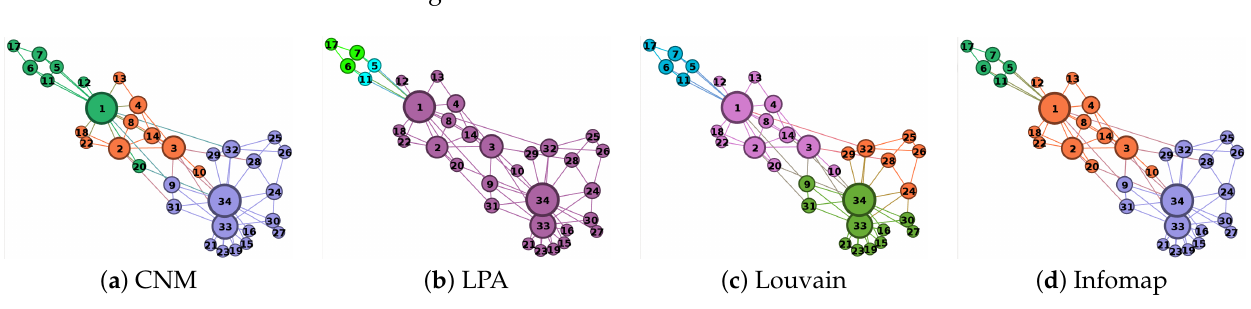
Figure 2. Comparison between different community detection algorithms on the Karate